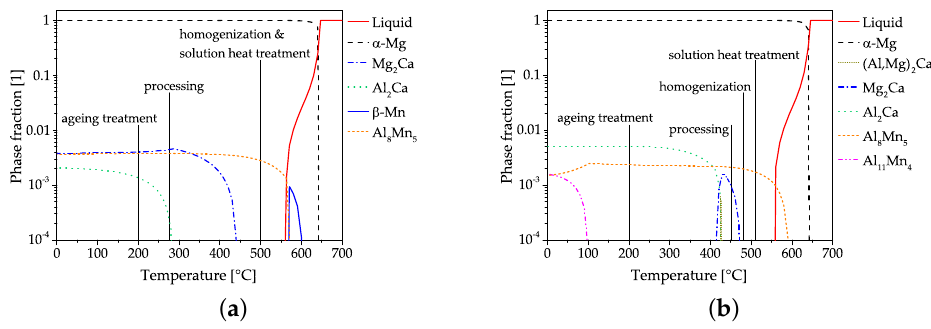
Figure 6. Comparison of CALPHAD calculations of Mg–Al–Ca alloys, including the used processing temperatures. Calculations were made using the alloy compositions given in refs. [23,71]; for further information, see Appendix A.2. ( a ) Mg-0.3Al-0.3Ca-0.4Mn; ( b )